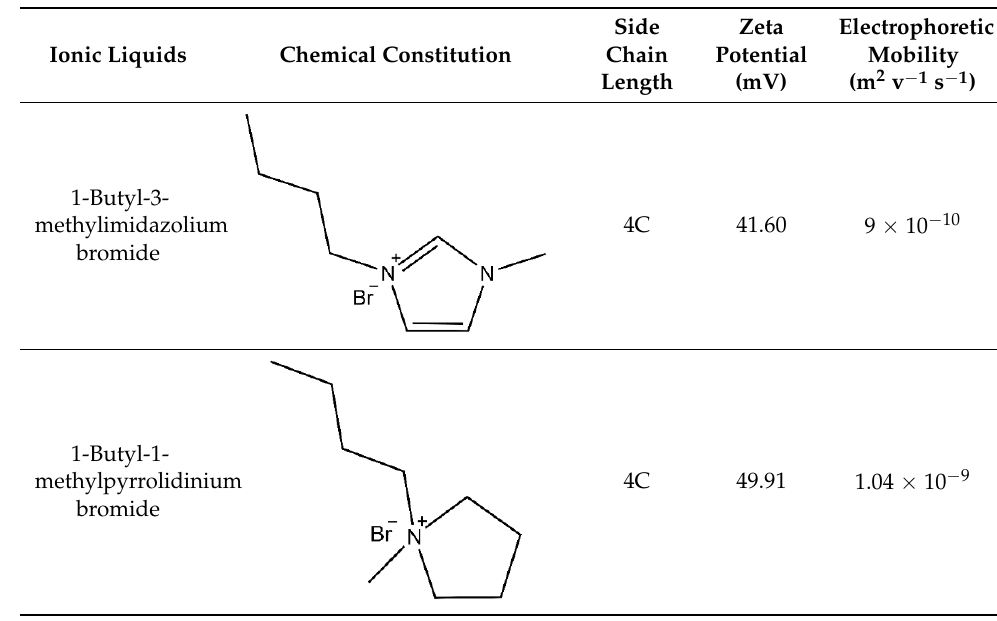
Table 2. Comparison of structures and properties of two ionic liquids .